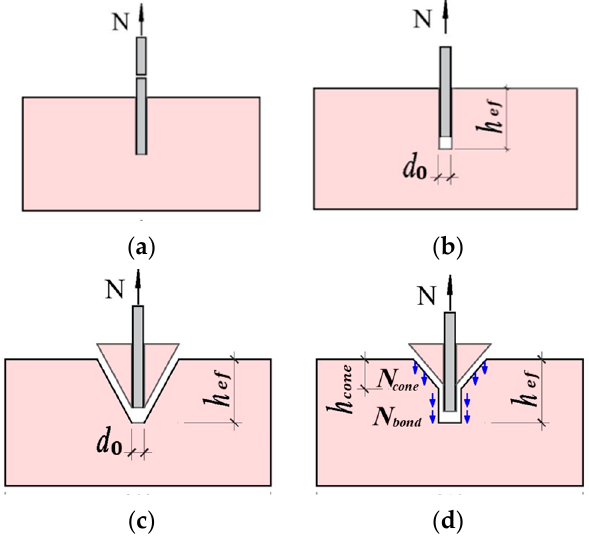
Figure 7. Predicted failure modes of pullout ( a ) Steel; ( b ) Bond; ( c ) Cone; ( d ) Combined cone–bond. Where; N is pullout load (kN); N cone is cone pullout load for combined cone–bond failure (kN); N bond is a bond pullout load for combined cone–bond failure (kN); d 0 is hole diameter (mm); h ef —effective depth of chemical adhesive (mm); h cone is the chemical adhesive depth of cone for combined cone–bond failure (mm). Table 6. The prediction formula of the pullout strength.